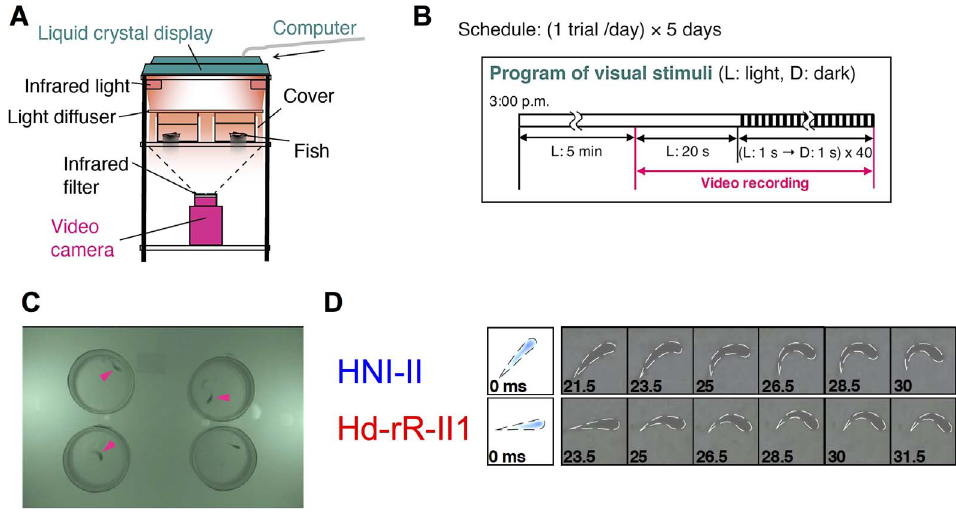
Figure 1. Experimental Design and Observed Startle Response. (A) Experimental apparatus with infrared imaging system. (B) Experimental program. (C) Images from infrared recording. Three individuals (top-left, top-right, and bottom-left, indicated by magenta arrowheads) exhibit C-start. (D) C-start of medaka. Fish bend their body in a ‘‘C’’ shape after a , 20-ms latency.